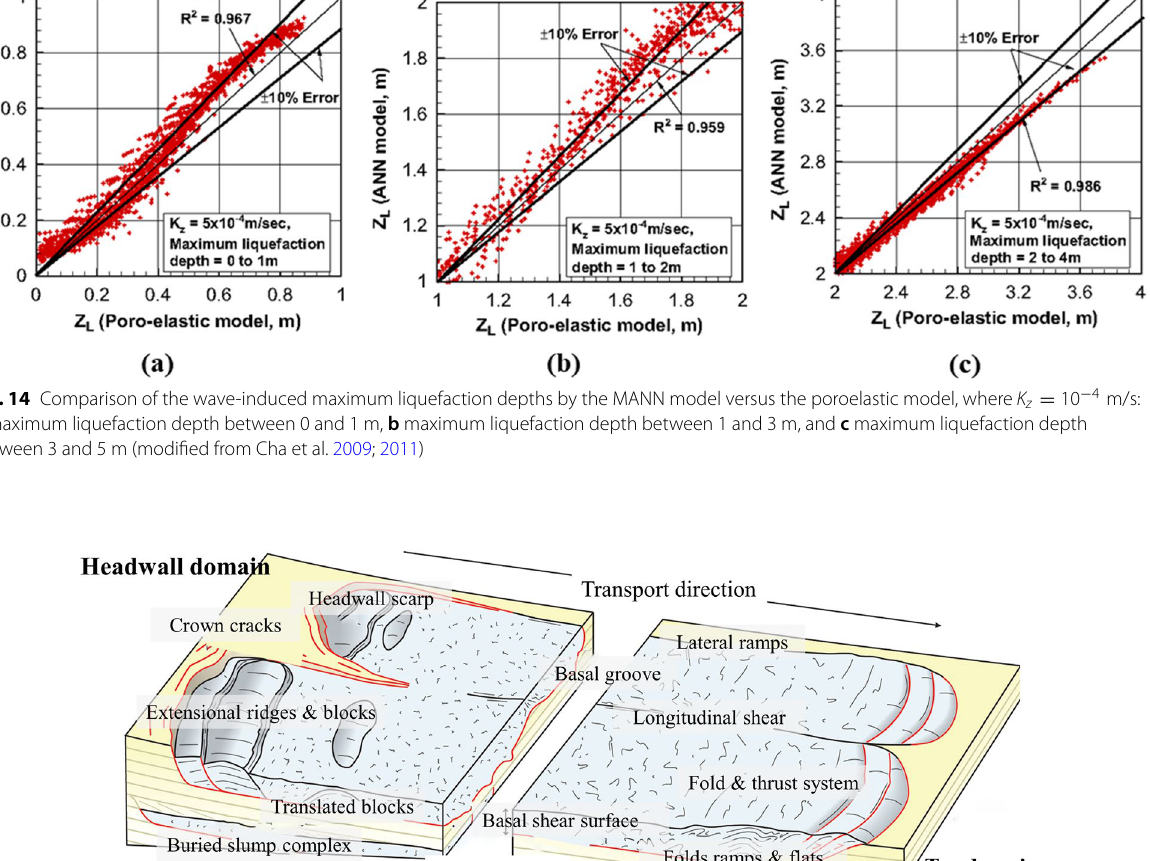
is shown in Fig. 15. Headwall scarps, extensional ridges and blocks are the main structures that characterize the headwall domain. Headwall scarps are the boundaries between submarine landslides and undeformed, upslope strata (Scarselli 2020). Extensional features, such as blocks or elongated ridges separated by normal faults, are commonly observed close to headwall scarps. The downslope translation of collapsed material can lead to intense deformation, promoting the formation of several structural features, which include lateral margins, ramps and flats of the shear surface, basal grooves, longitudinal shear zones, folds and translated blocks (Scarselli 2020). Ramps are the steep segments of the basal shear surface that cut up or down through stratigraphy; flats are seg- ments of the basal shear surface that are parallel to the bedding and interposed between ramps. Basal grooves or striations are linear to sinuous depressions in the basal shear surface (Bishop 1955; Zhu et al. 2015).